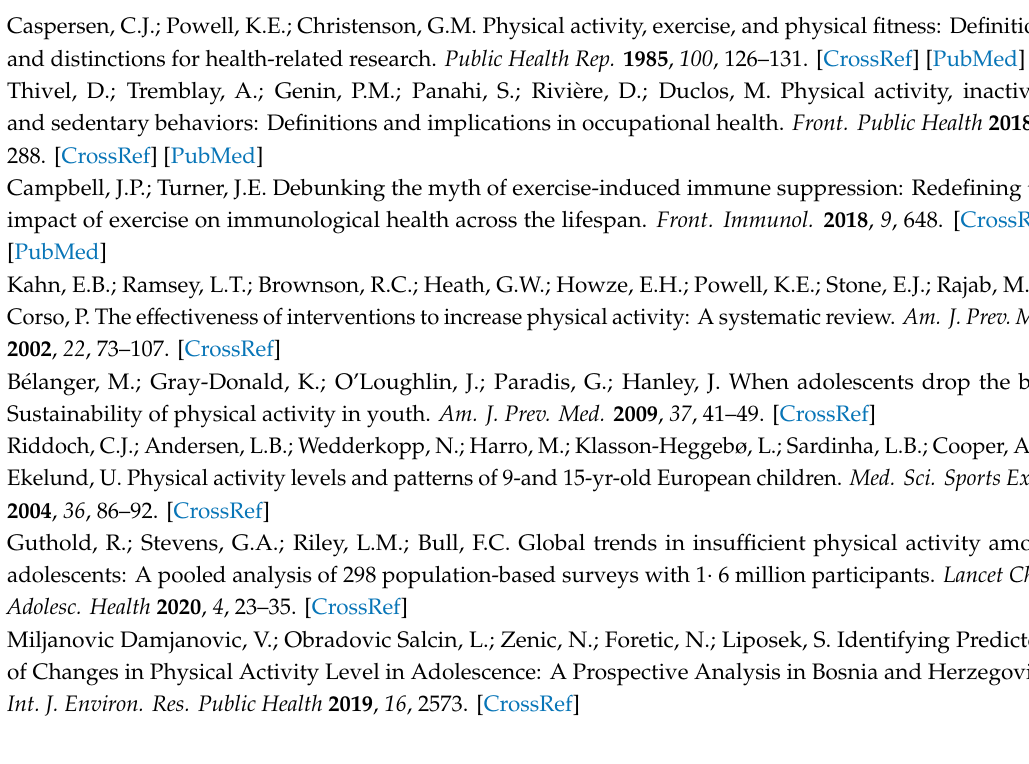
Table S1: Frequencies (F) and percentages (%) in studied sociodemographic-, parental- and familial factors with di ff erences between boys and girls (MW—Mann Whitney